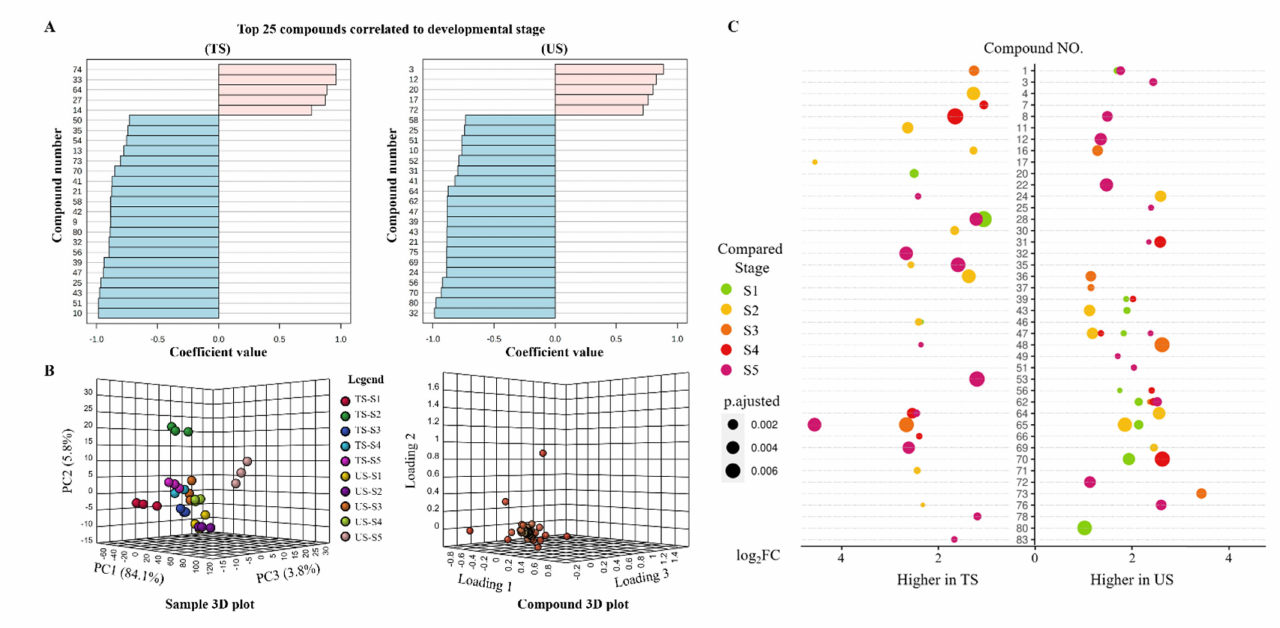
Figure 1. Volatile profiles of grape berries. Compounds are labeled with numbers consistent with Tables S2 and S3. ( A ): The top 25 compounds correlated to developmental stages. ( B ): 3D plot of principal component analysis; ( C ): Significantly varied compounds between US and TS at each stage (FC > 2, p < 0.01). TS: Turpan sample; US: Urumqi